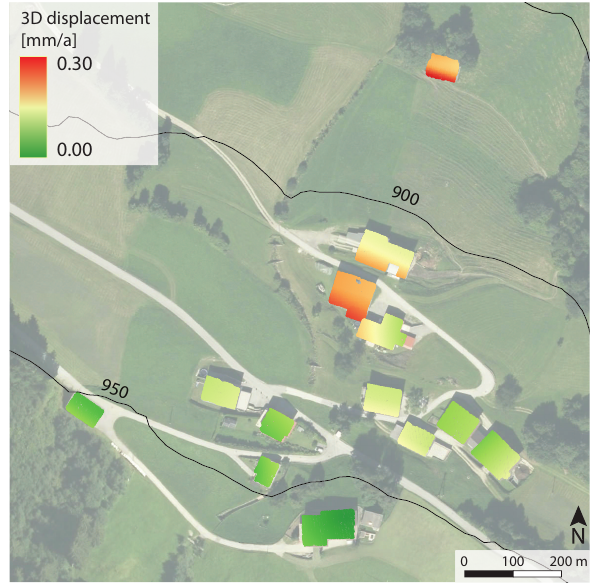
Figure 9. Derived 3D displacement vectors derived from the laser scanning data showing deformation of extracted roofs in the area affected by the active